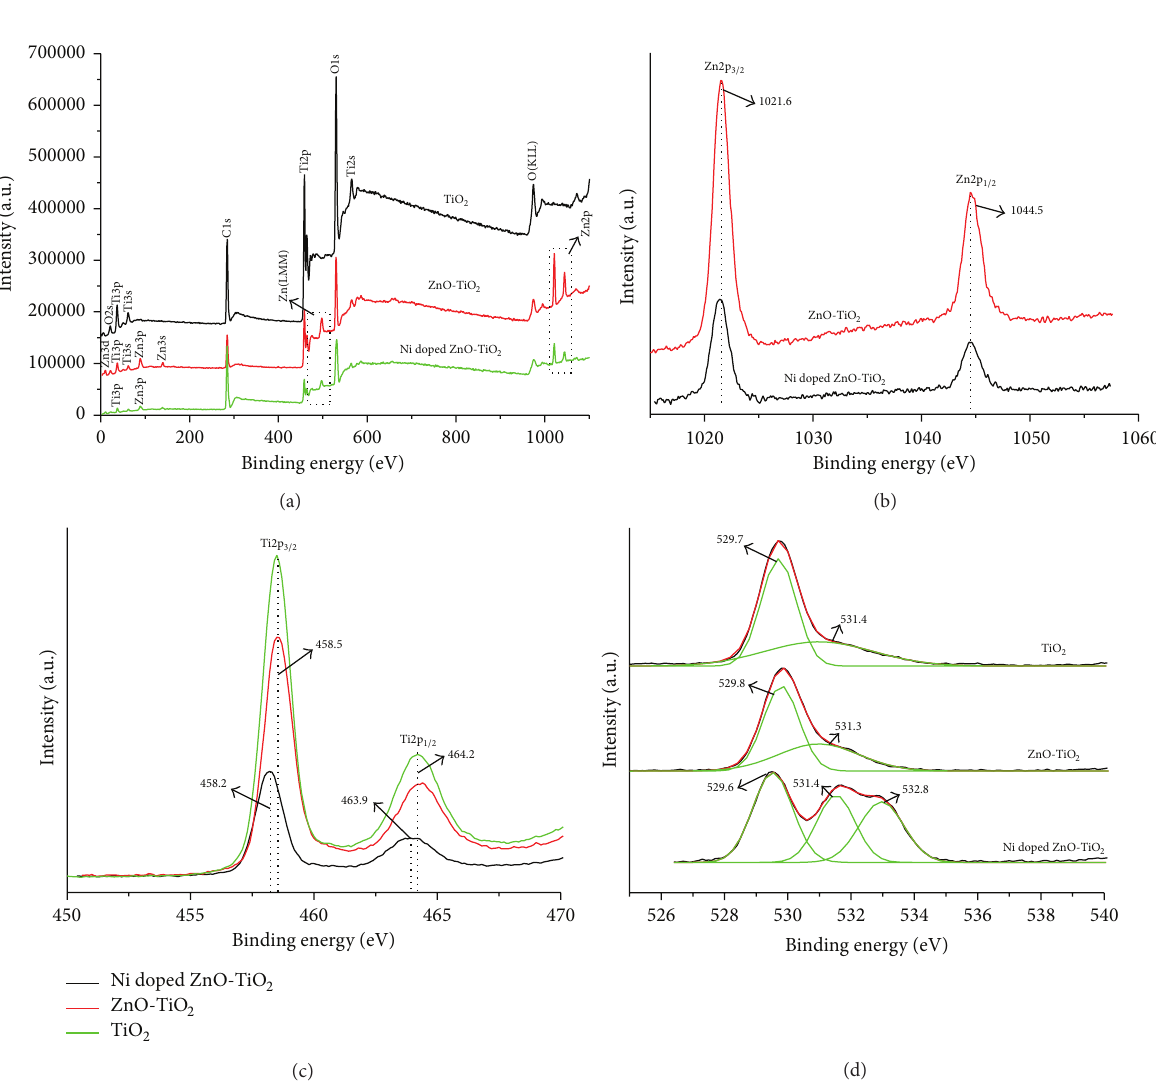
Figure 4: XPS spectra of samples: (a) XPS survey spectra, (b) Zn2p, (c) Ti2p, and (d) O1s state.